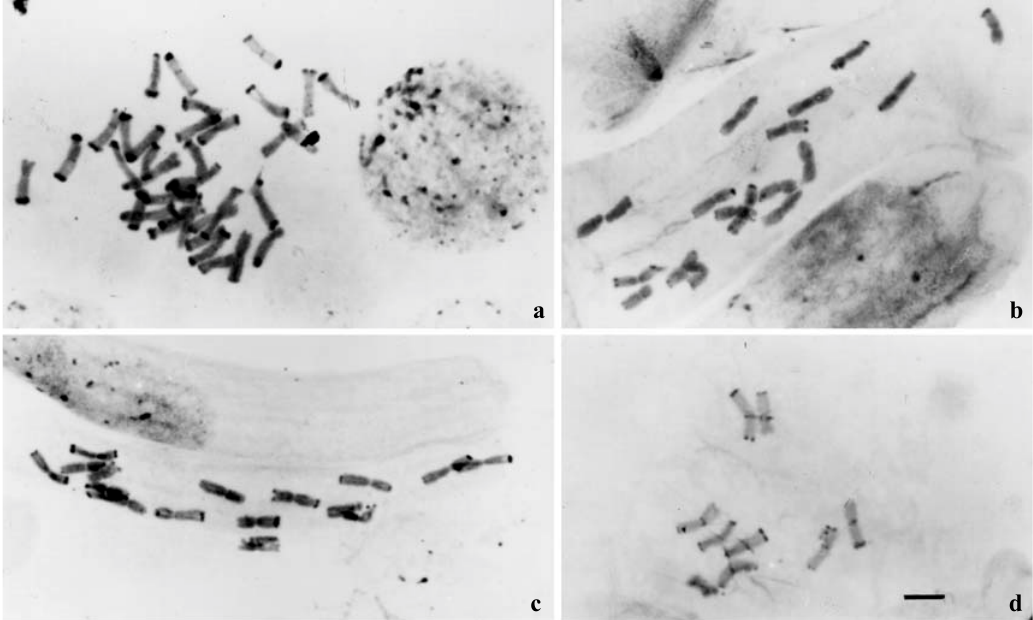
Figure 1 - C-banded metaphase chromosomes of Santolina species. a , Santolina sp. (2n = 36). b , S. rosimarinifolia (2n = 18). c , d , S. chamaecyparissus (2n = 18). Note proximal bands in most chromosomes of the tetraploid species and at the partial metaphase in d . Bar in d represents 5 µ